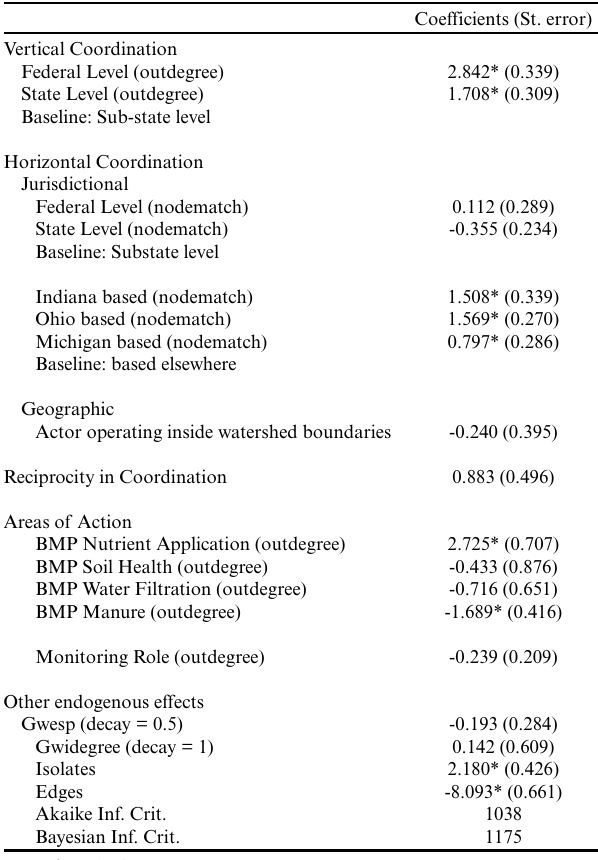
Table 1 . ERGM model parameter estimates. BMP, best management